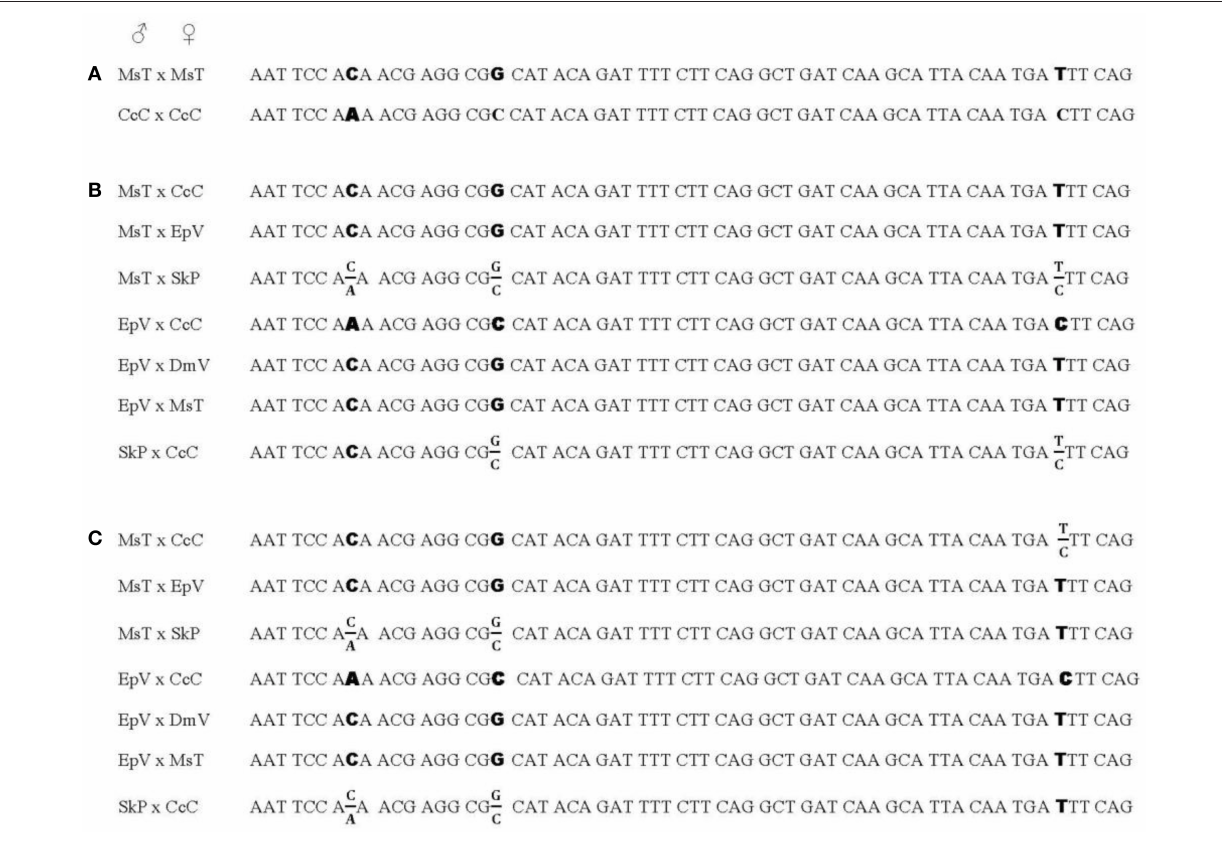
FIGURE 5 | Variation among Cotesia congregata PTP-p gene sequences (A) MsT and CcC pure lines, (B) F 1 hybrid crosses, including hybrid crosses between MsT and CcC and other field collected host-foodplant complex sources of C. congregata that produced progeny (see Table 1 ) and (C) in vivo expressed transcripts from host post-parasitization by F 1 hybrids in (B)